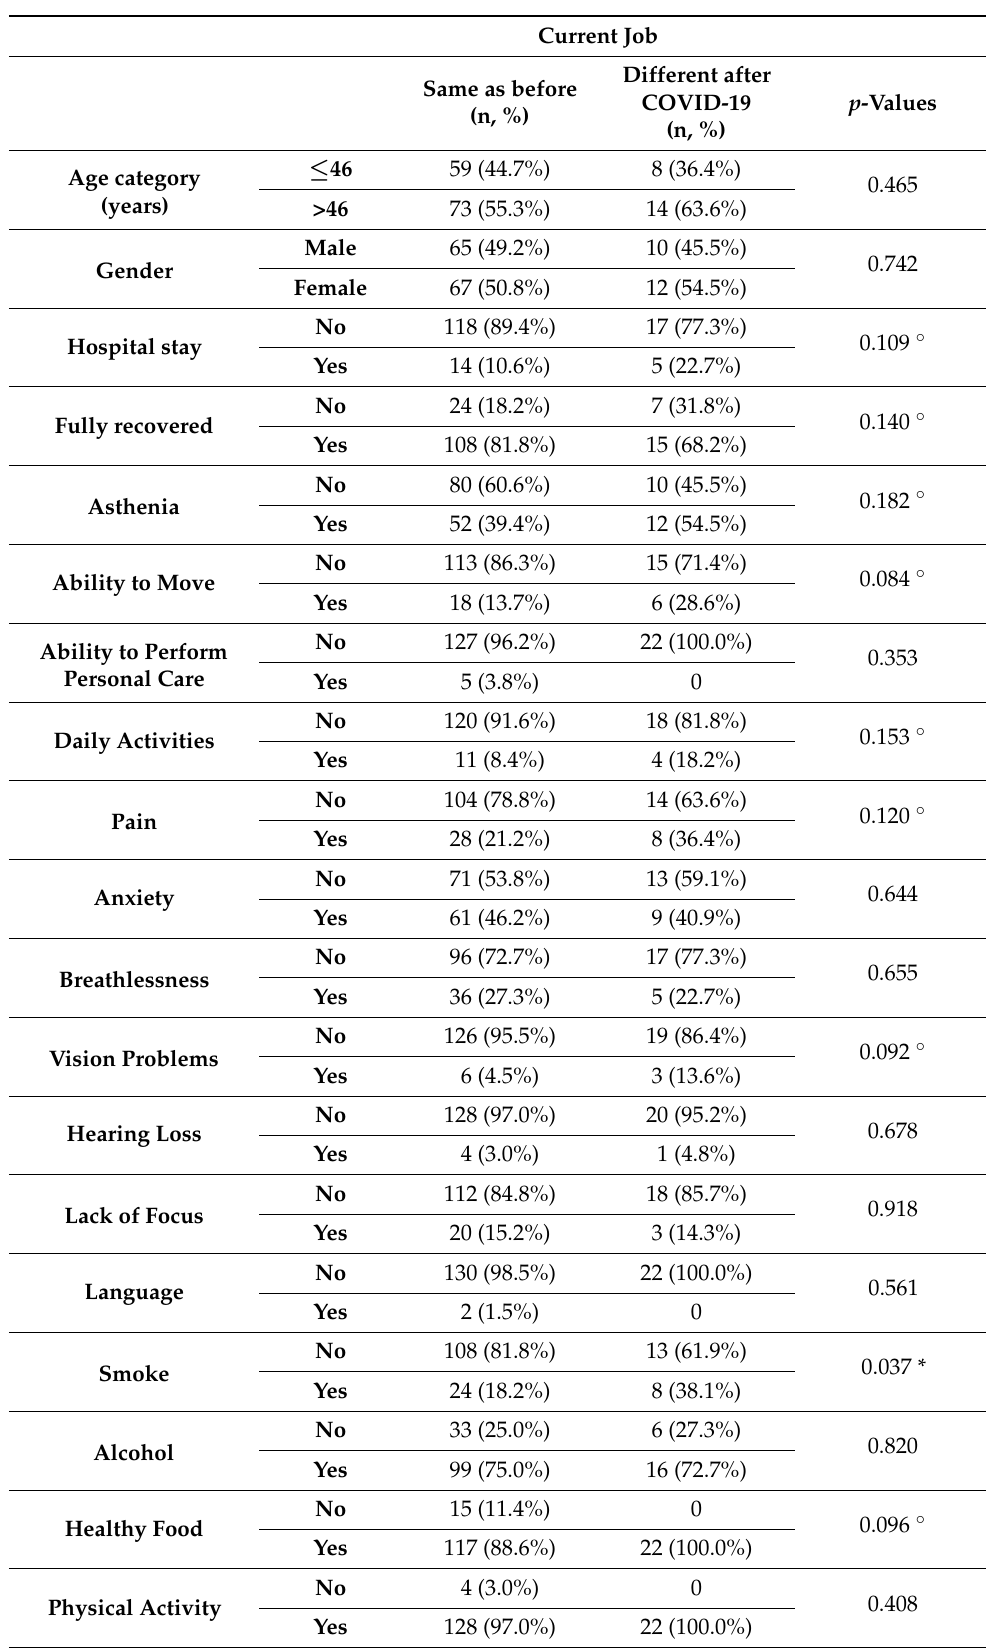
Table 1. Chi-square test correlating current work status (* p ≤ 0.05; ◦ p ≤ 0.25, included in the